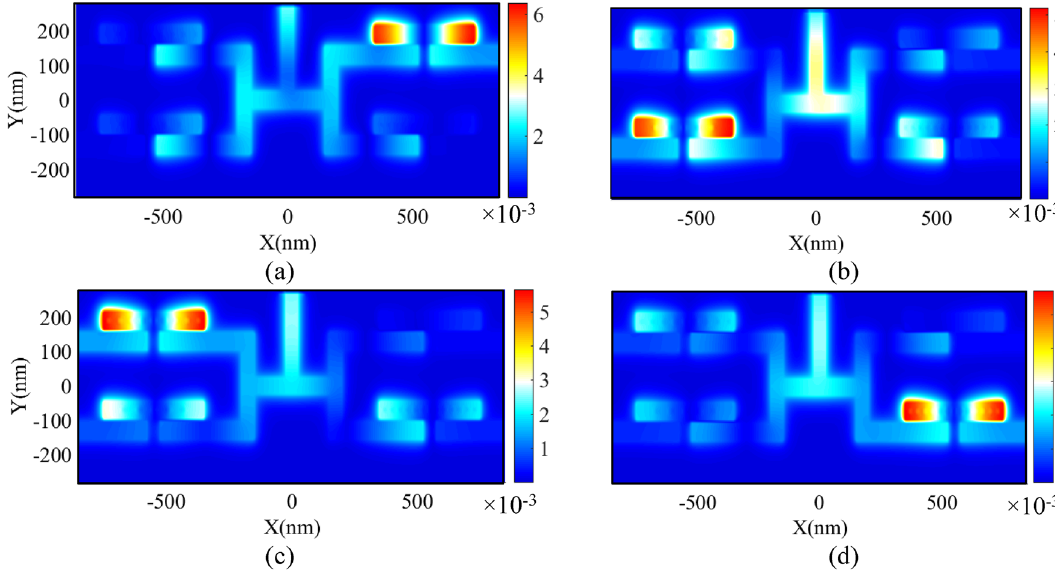
Figure 11. Field profile of | H z | for 1 × 4 DEMUX at the wavelength of (a) 1377, (b) 1576, (c) 1682 and (d) 1789 nm.